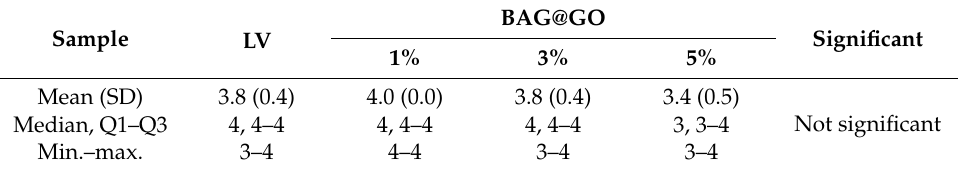
Table 1. Adhesive Remnant Index (ARI) scores of tested orthodontic bonding adhesives.